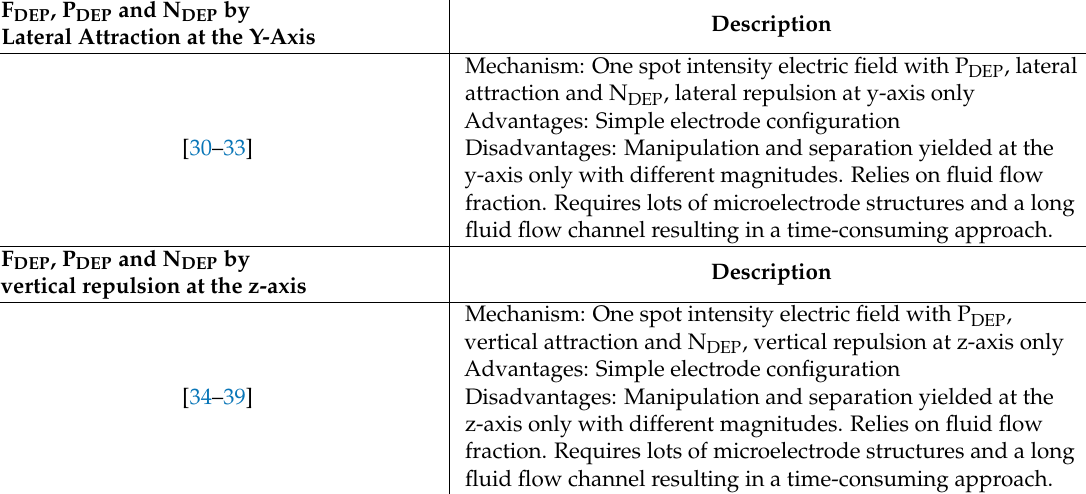
Table 1. The lateral, vertical and combination of lateral and vertical motion